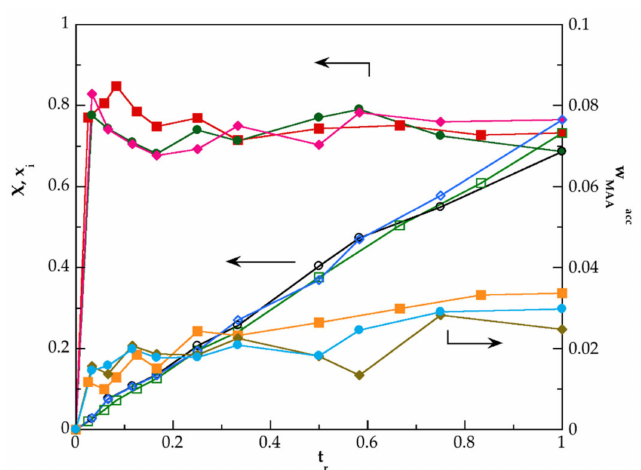
Figure 4. Progress of instantaneous x i (close symbols) and global X (open symbols) conversions and weight fraction of residual monomer, w acc (close symbols) with relative time for the polymerization MAA of pure MAA to synthesize the PMAA 6 ( (cid:4) ) or for the polymerization of a mixture of MAA and (cid:50) G 3.0 -CNTs-PAMAM-NH 2 to prepare the nanocomposites PMAA–CNTs 11 ( • ) at a monomer feeding rate of 0.3